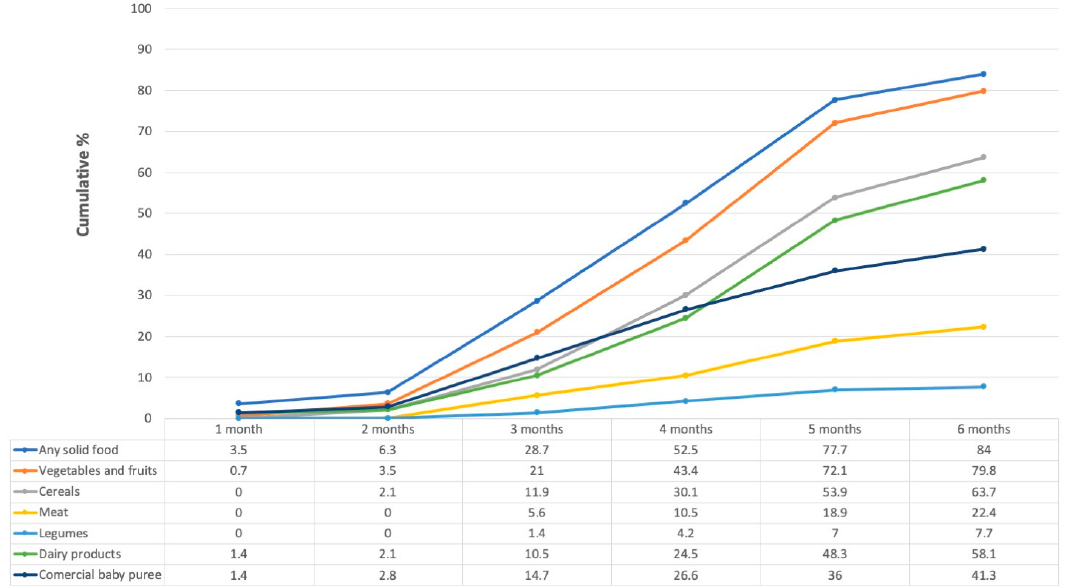
Figure 2. Cumulative percentage of solid foods consumed over the first six months of life. Numbers in the table represent percentages. Those in the “Any solid food” category are not the sum of the other categories, since some women could have given more than one food during the same month.